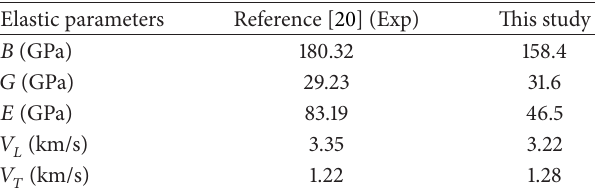
Table 2: Comparing earlier experimental data of 𝐵 , 𝐸 , 𝐺 , 𝑉 𝐿 , and 𝑉 𝑇 values for Au with our